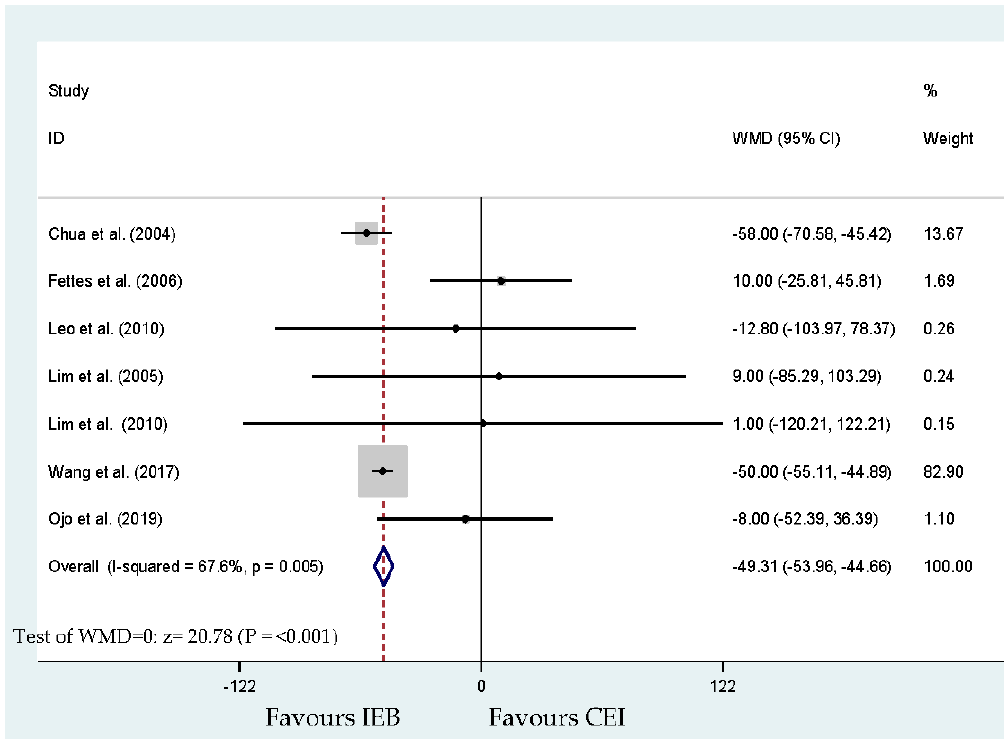
Int. J. Environ. Res. Public Health 2020 , 17 , x FOR PEER REVIEW Figure 5. Overall e ff ect for the requirement of anesthetic interventions. Figure 5. Overall effect for the requirement of anesthetic interventions.